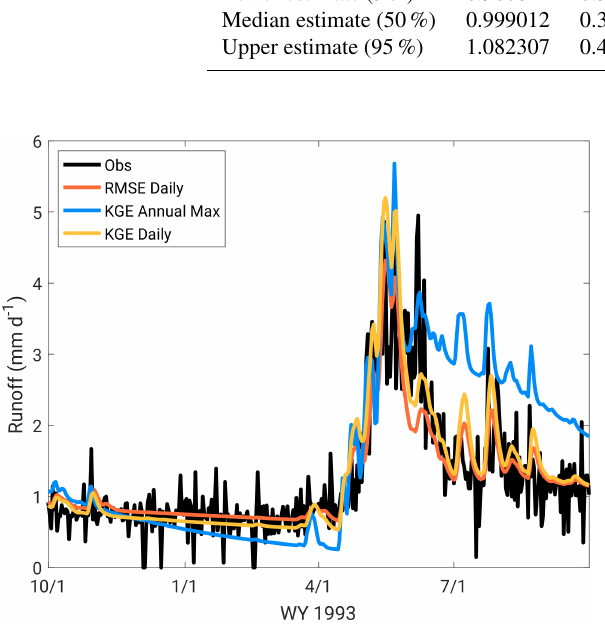
Figure 5. Island Park calibration period runoff for water year (WY) 1993, with RMSE using daily flow, KGE using daily flow, and KGE using annual maximum